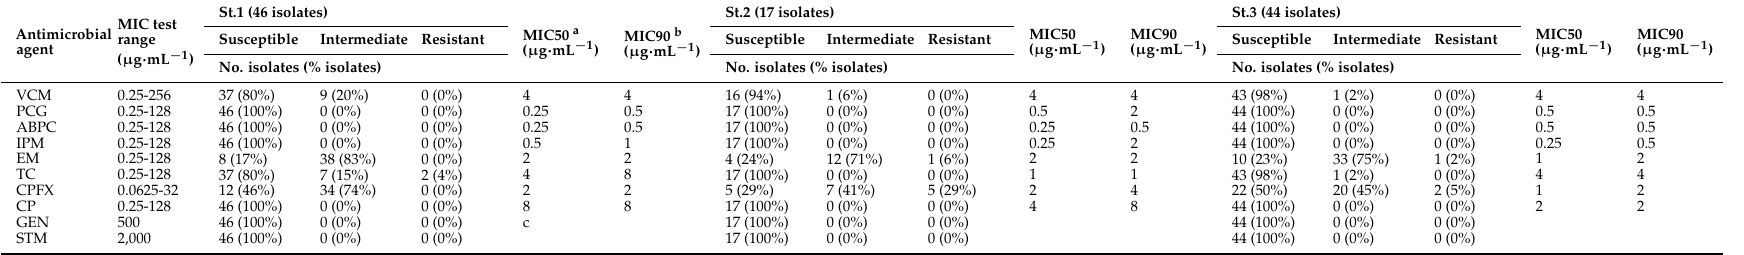
Table 2. Antibiotic susceptibilities of enterococci isolated in Yae River using Van-mEI agar.